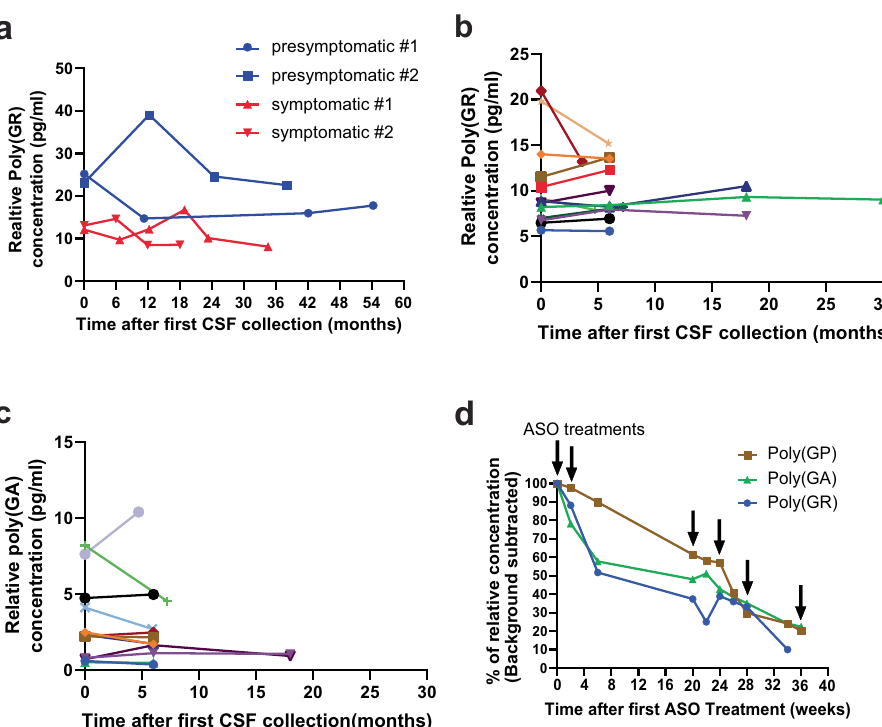
Fig. 4 ASO treatment in a patient with C9ORF72 -ALS decreases CSF DPR levels. a Poly(GR) levels in CSF were generally stable over time in two symptomatic and two asymptomatic patients with C9ORF72 mutations. b Longitudinal trend of poly(GR) levels in CSF from a larger cohort of patients with C9ORF72 mutations. c Longitudinal trend of poly(GA) levels in CSF from patients with C9ORF72 mutations. d After ASO treatment, CSF poly(GP), poly(GA), and poly(GR) levels in a patient with C9ORF72 -ALS decreased over time. Note: colors in panels b , c do not indicate the same patients. The fi fth time point value for symptomatic patient 2 in panel a and the last time point for poly(GR) value in panel b were above background but below the lower limit of detection and were not included. Source data are provided as a Source Data fi